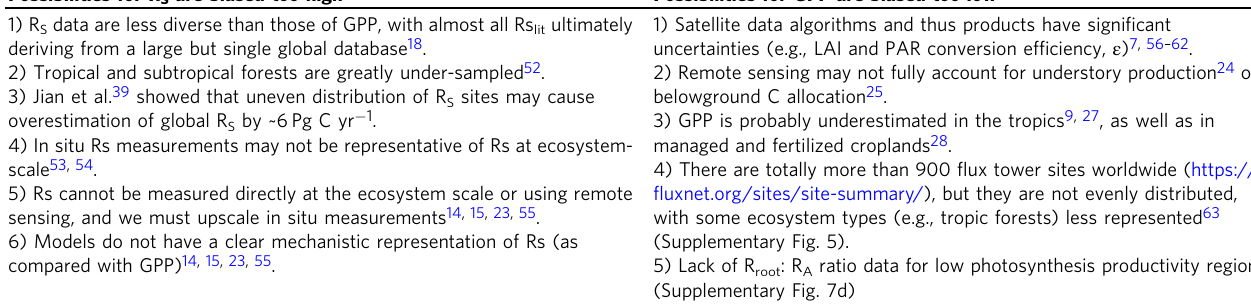
Table 2 Summary of uncertainties and possible biases: factors that might explain why gross primary production (GPP) would be biased low, and/or soil respiration (R S ) too